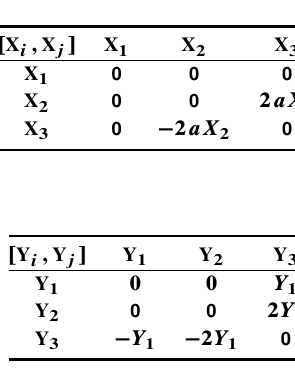
Table 1. The commutator table of g BBM